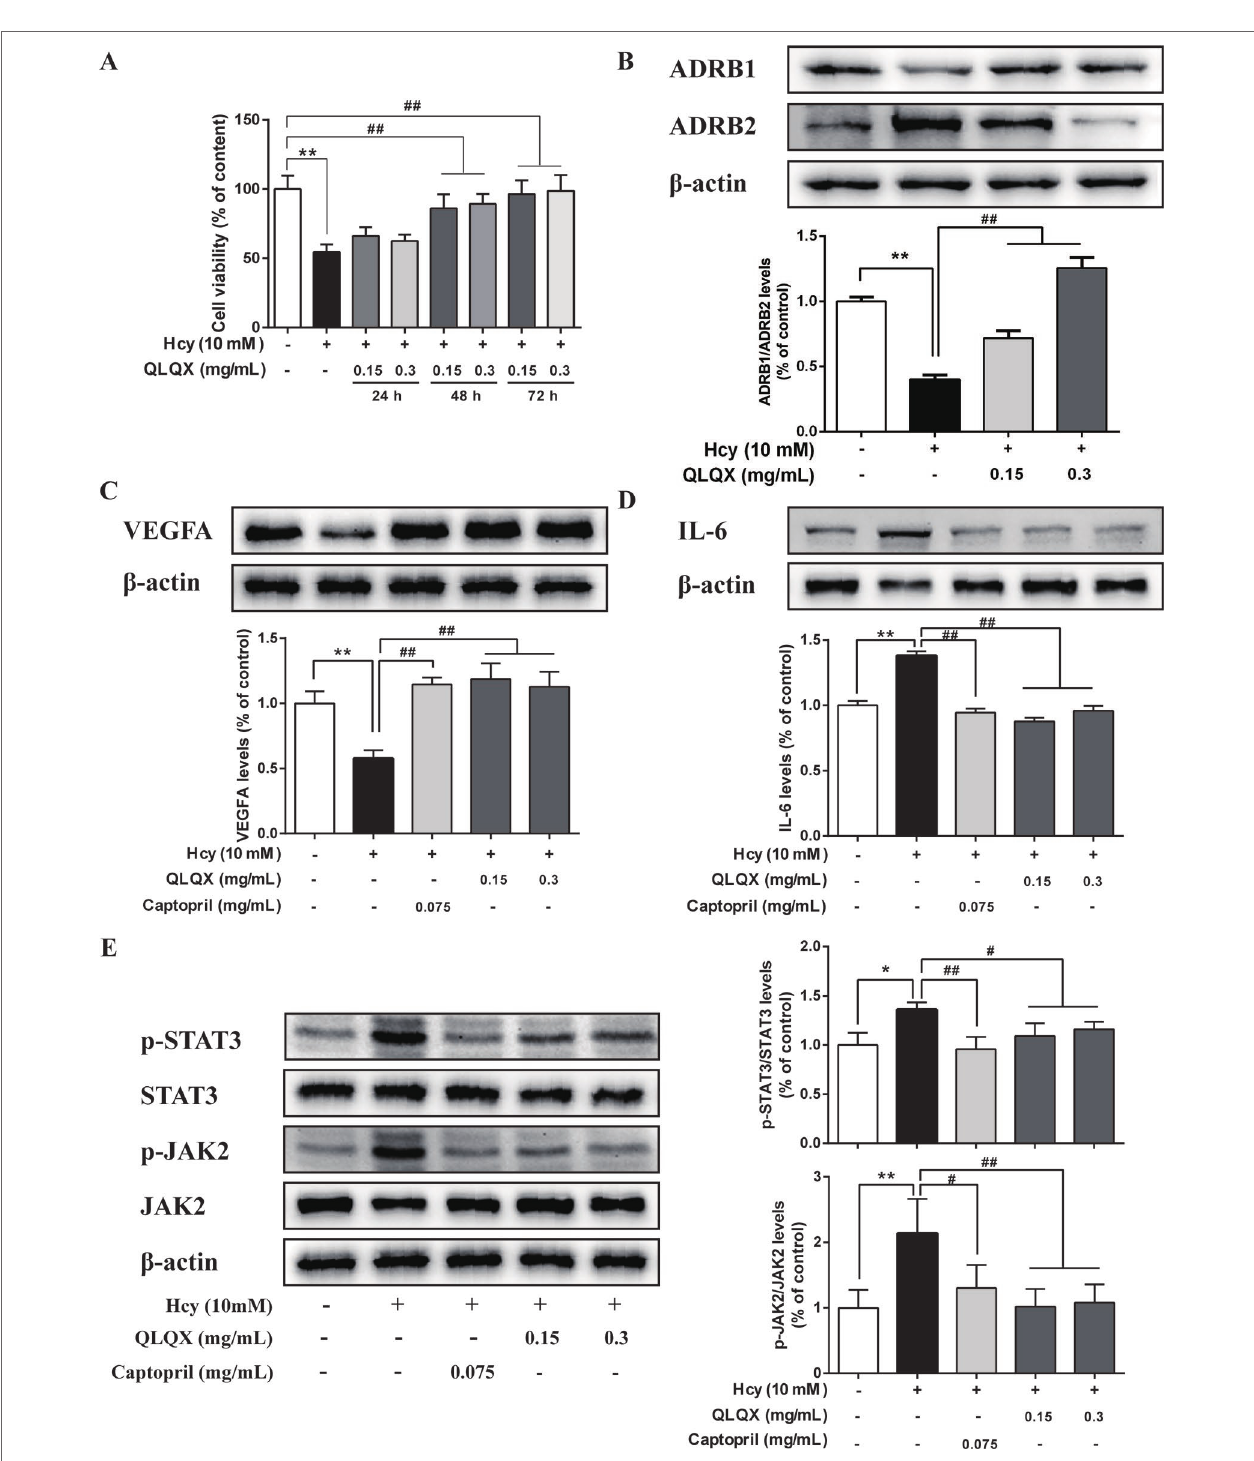
FIGURE 6 | Experimental validation of key targets and pathway in HCMEC. (A) Effect of QLQX treatment on Hcy-induced HCMEC cell viability. HCMECs were treated with 0.15 mg/mL and 0.3 mg/mL QLQX for 24, 48, and 72 h, after then cells were treated with Hcy for 24 h. The cell viability was determined using the MTT assay. (B) Effect of QLQX treatment on Hcy-induced ADRB1/Anti-ADRB2 ratio in HCMEC. (C) Effect of QLQX and captopril treatment on Hcy-induced VEGFA expression in HCMEC. (D) Effect of QLQX and captopril treatment on Hcy-induced IL-6 expression in HCMEC. (E) Effect of QLQX and captopril treatment on Hcy- induced phosphorylation of STAT3/JAK2 signaling pathway. HCMECs were treated with 0.075 mg/mL, 0.3 mg/mL QLQX for 48 h and exposed to 10 mM Hcy for a further 24 h. The levels of VEGFA, IL-6, p-STAT3, and p-JAK2 expression were determined by western blot. Data were presented as mean SD of three independent experiments. * p < 0.05 or ** p < 0.01 compared with the Hcy-untreated control. # p < 0.05 or ## p < 0.01 compared with the Hcy-treated